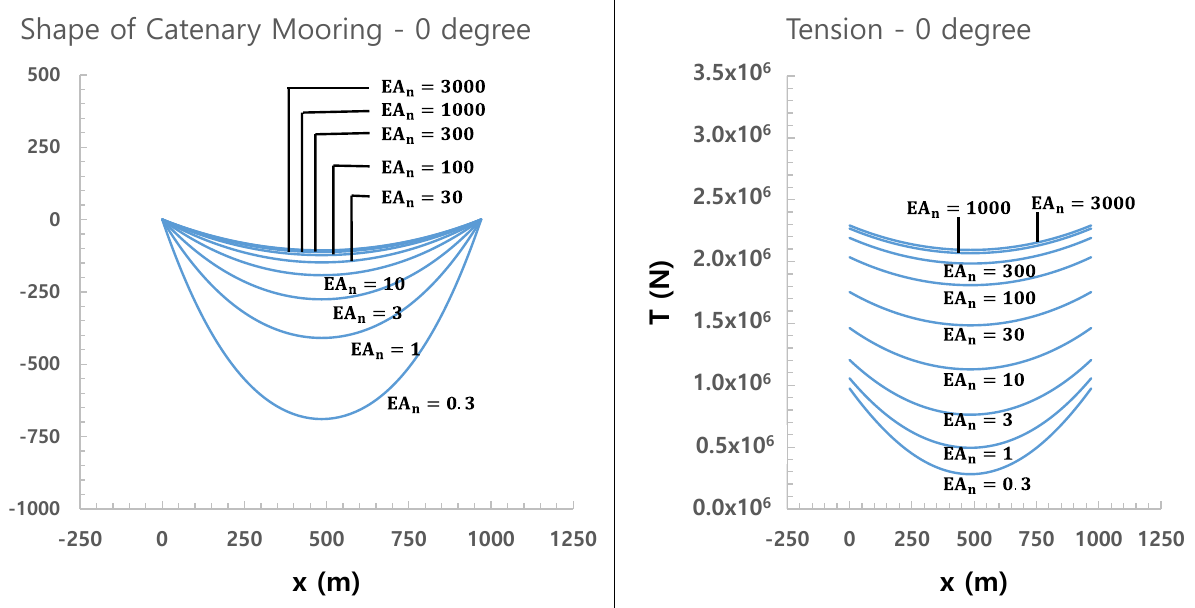
Figure 4. Comparison between analytical solution and simulation results obtained using the developed program.